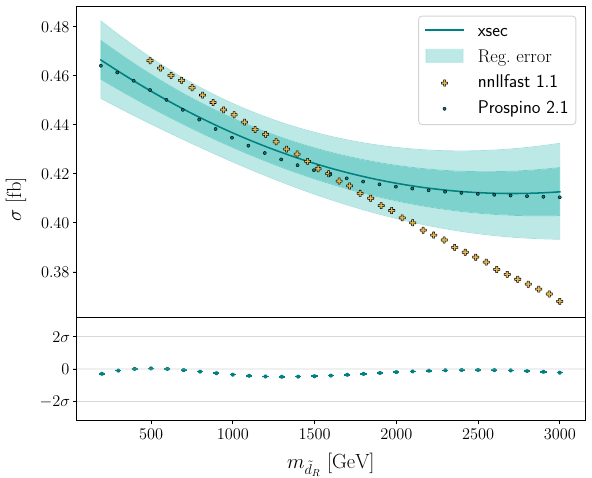
Fig. 6 Gluino pair-production cross-section as a function of the ˜ d R mass. All other squark masses are fixed at 1TeV and the gluino mass is set to 2TeV. Shown is the central xsec prediction (solid line), the 1 σ and 2 σ regression error bands (shaded regions), the Prospino values (dots) and the corresponding NNLL-fast NLO result (crosses) ˜ ˜ u d R . While less L and 2TeV for the plot with